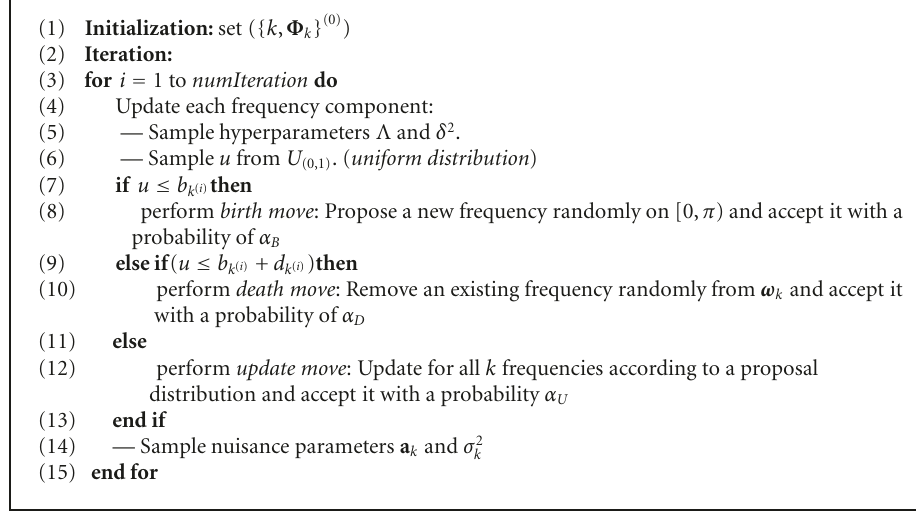
Algorithm 1: A rjMCMC algorithm for frequency